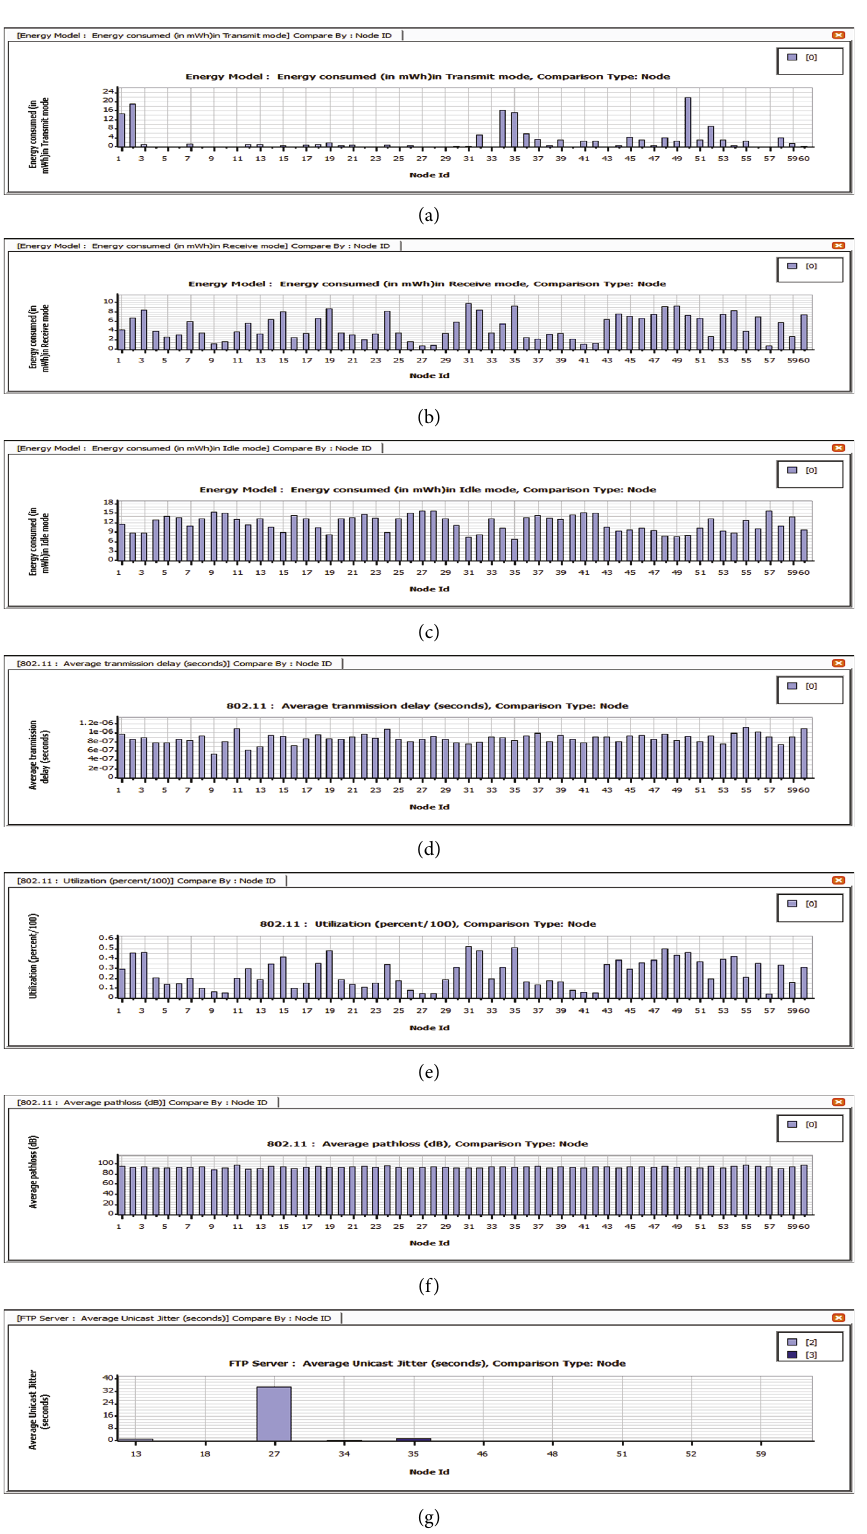
Figure 9: (a) Transmit mode energy consumption of DSR for FTP deployment. (b) Receive mode energy consumption of DSR for FTP deployment. (c) Idle mode energy consumption of DSR for FTP deployment. (d) Average transmission delay of DSR for FTP deployment. (e) Percentage of utilization of DSR for FTP deployment. (f) Average pathloss of DSR for FTP deployment. (g) Average unicast jitter of DSR for FTP